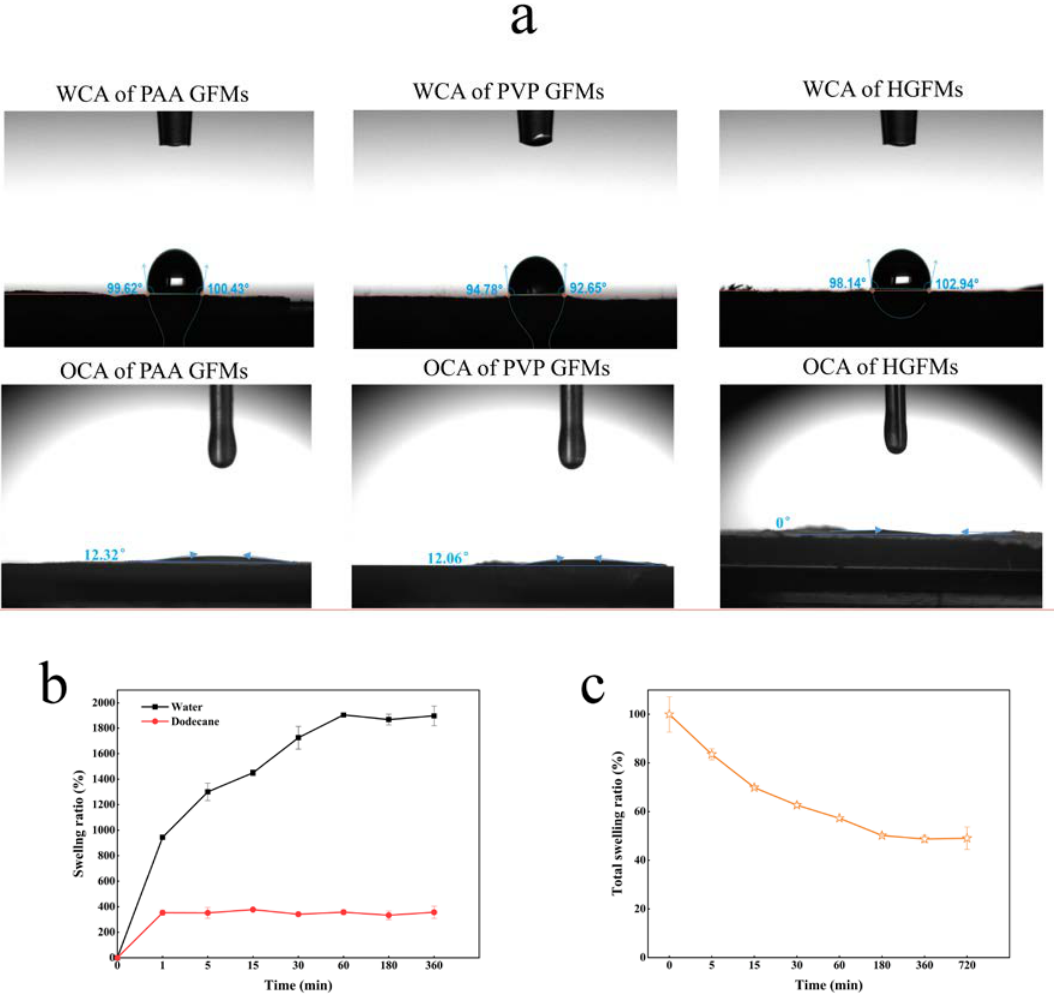
Figure 3. Wettability and swelling properties of different fiber membranes ( a ); WCA and oil contact angle (OCA) of different fiber membranes ( b ); swelling curve of HGFMs as a function of time ( c ); swelling curve of HGFMs as a function of time obtained by using a procedure of saturated swelling with water followed by infiltration with dodecane. The following parameters were used to prepare the HGFMs corresponding to a-c: an electrospinning speed ratio of PAA/PVP of 5/8, an electrospinning time of 8 h, a thermal crosslinking time of 45 min, and a UV crosslinking time of 15